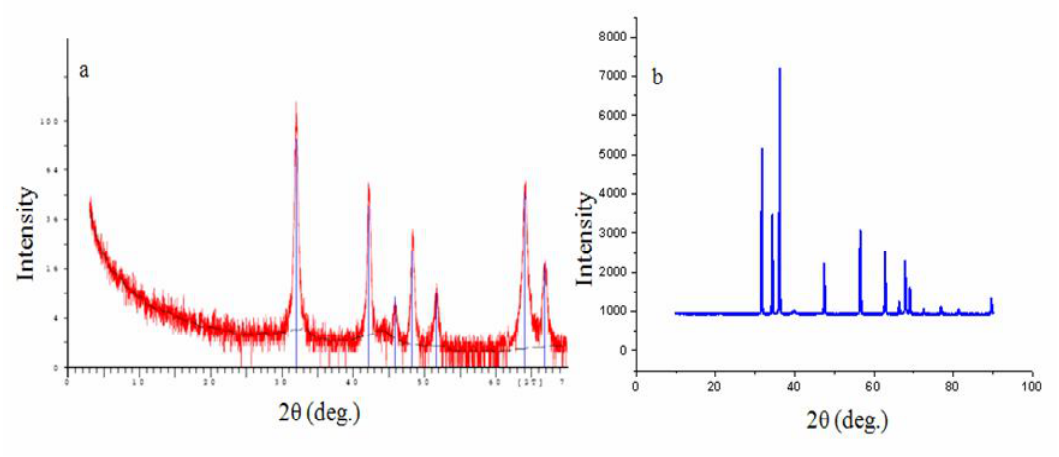
Fig. 1. XRD pattern of a) TiO